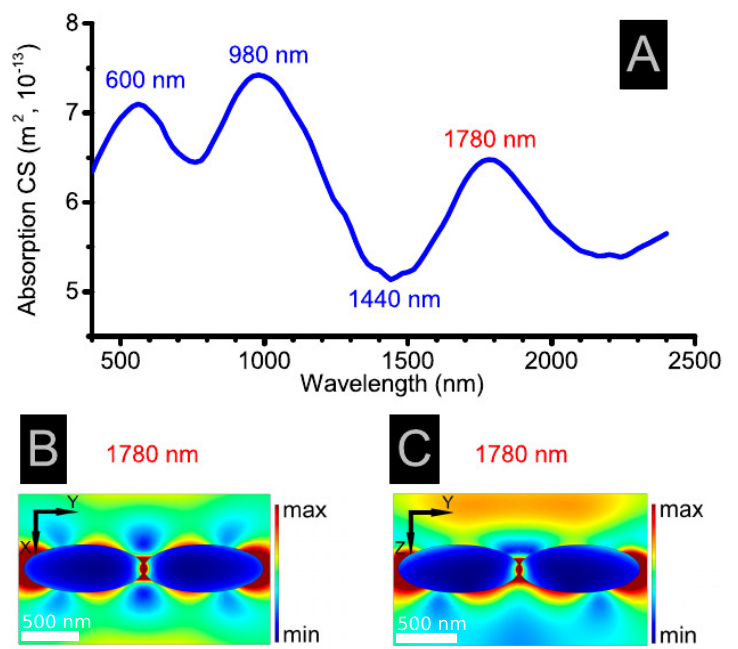
Figure 8. ( A ) Coupled spheroids with semiaxes of 500, 200 and 200 nm in end-to-end configuration. Electric field intensity maps at TSP maximum—1780 nm in the XY-plane ( B ) and YZ-plane ( C ) are